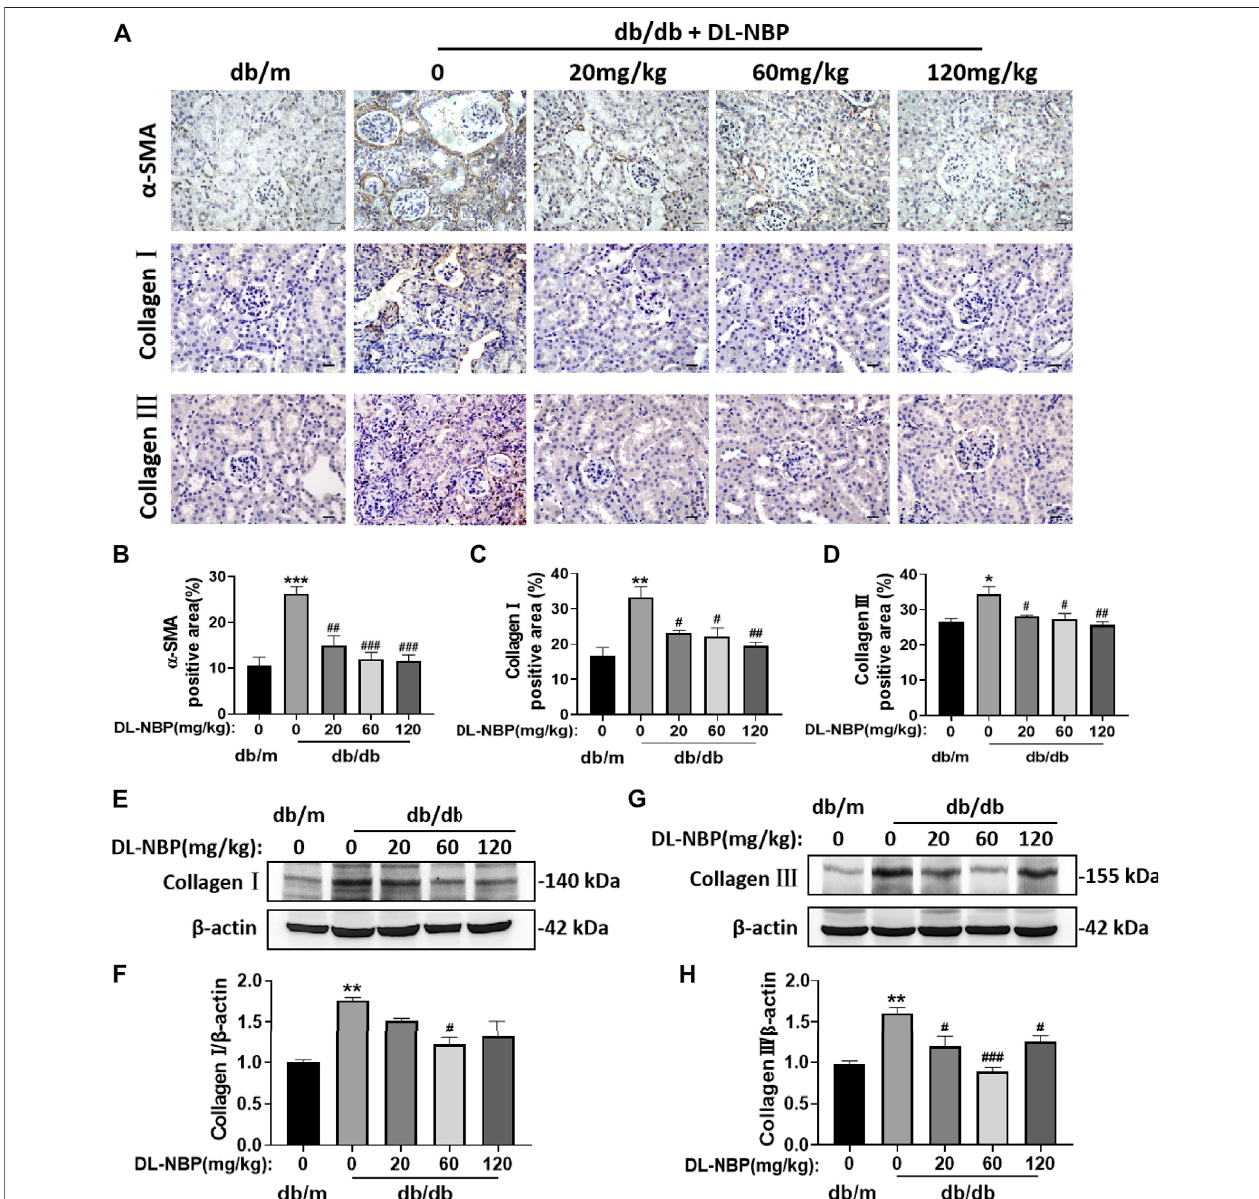
FIGURE3| DL-NBPtreatmentamelioratesdiabetes-inducedrenal fi brosis. (A – D) Immunohistochemicalstaining(originalmagni fi cation × 400)andquanti fi cationof α -SMA, collagen I, and collagen III in kidney of mice from each group ( n (cid:2) 3). Scale bar (cid:2) 20 μ m. (E – H) Western blotting and quanti fi cation of collagen I and collagen III from the renal tissue of each group ( n (cid:2) 3). Data are presented as the mean ± SEM. * p < 0.05, ** p < 0.01, *** p < 0.001 vs. db/m control group; # p < 0.05, ## p < 0.01, ### p < 0.001 vs. db/db mice. α -SMA, α -smooth muscle actin.